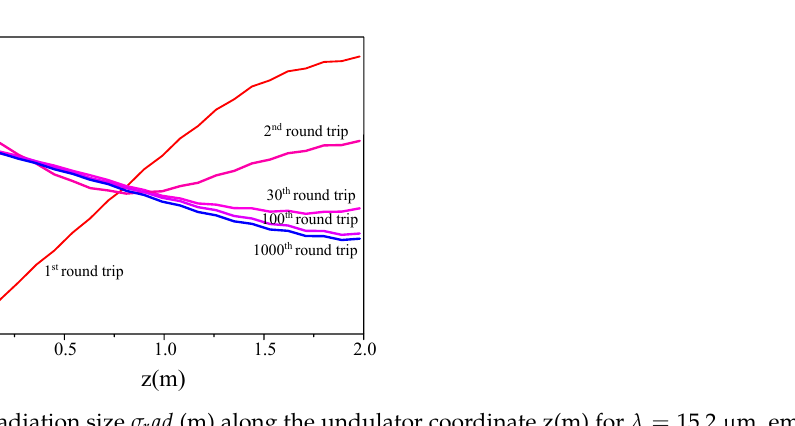
Figure 5. Radiation size σ r ad (m) along the undulator coordinate z(m) for λ = 15.2 µ m, emittance (cid:101) = 1 mm mrad, loss = 6% for different round trip numbers.